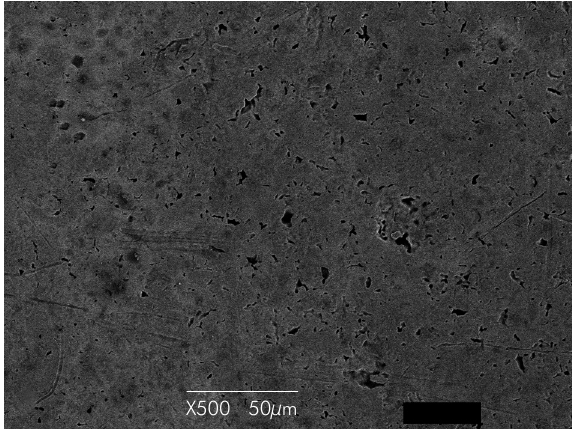
Figure 3. Photomicrograph from Group ABZ at 500x